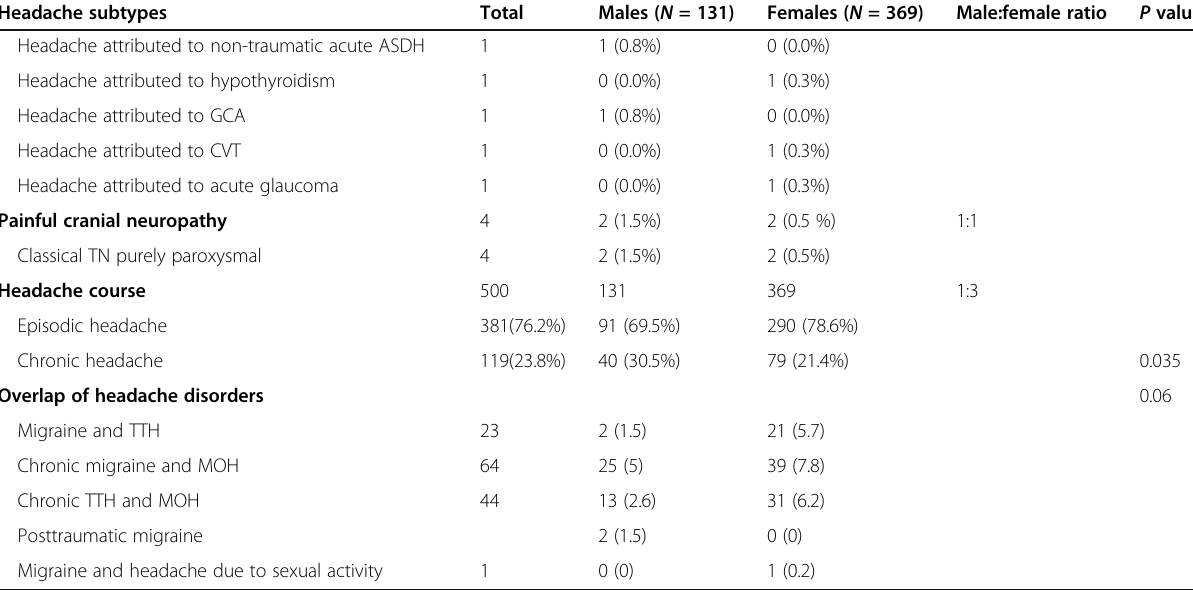
Table 3 Frequency of headache subtypes between male and female (Continued) Headache